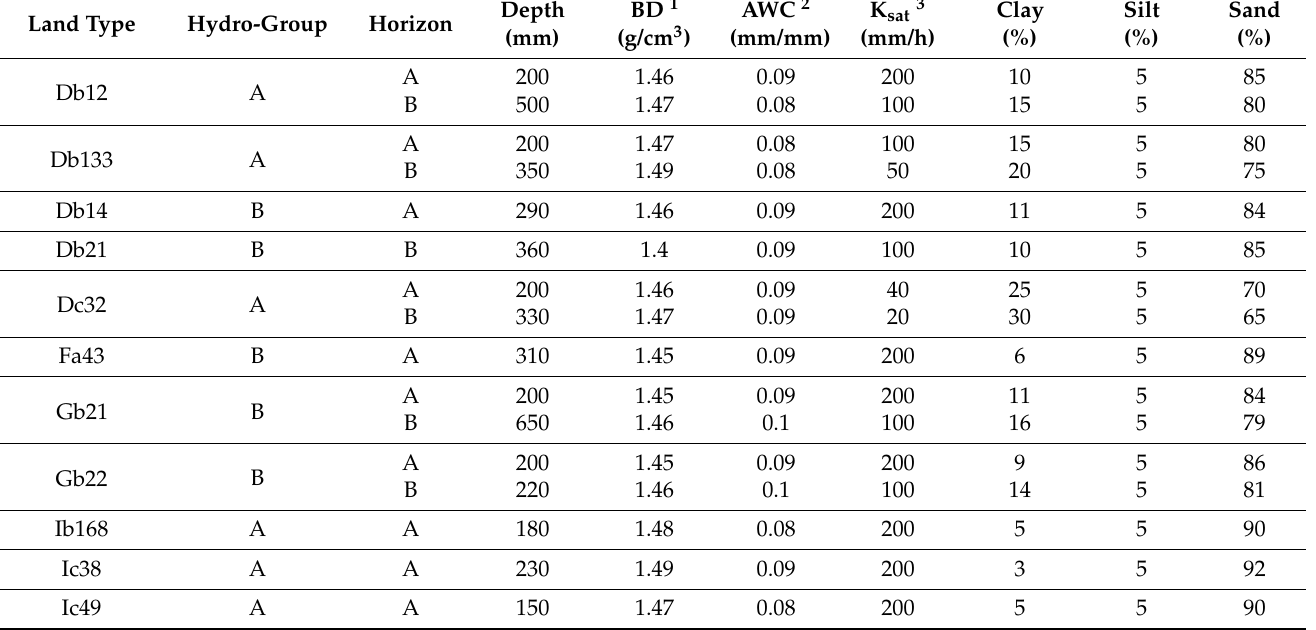
Table 2. Land types and their respective hydropedological groups and main SWAT+ hydraulic properties of the LTSM